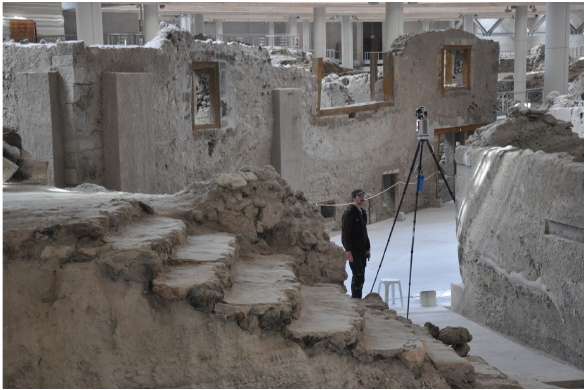
Figure 5: Ground-penetrating radar measurements on top of Kokkino Vouno, one of the few sites on Thera where the